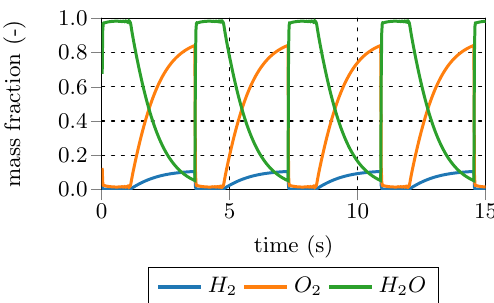
Figure 4. Example oscillating behavior for hydrogen combustion in a perfectly stirred reactor (PSR).